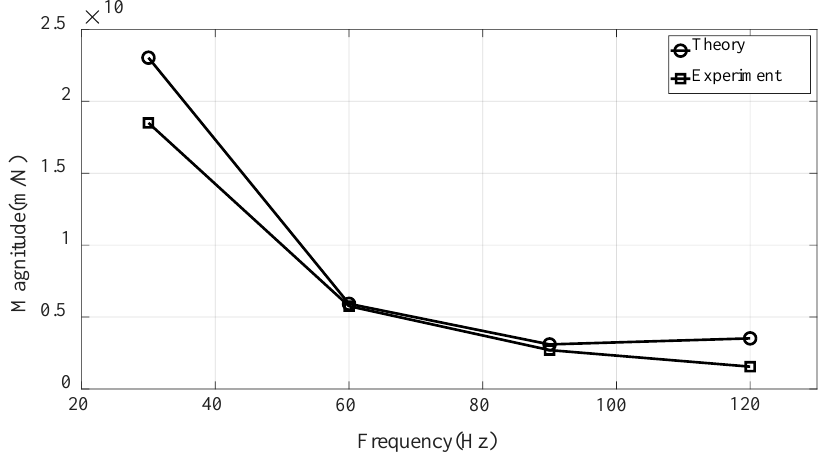
Figure 7. Comparison of magnitude of frequency response functions.